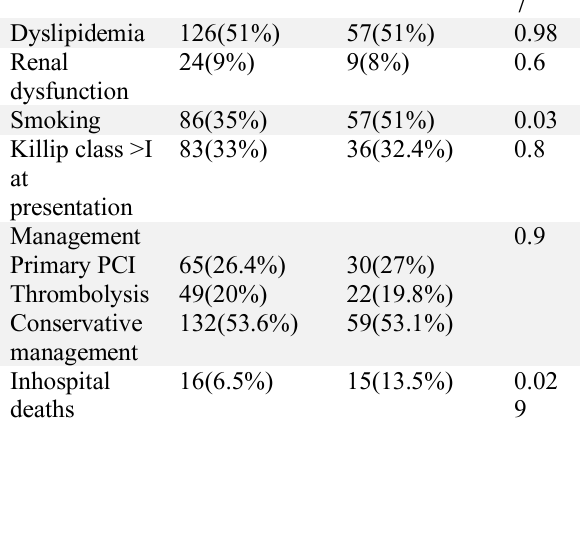
Table 1: Baseline characteristics, management and mortality of patients